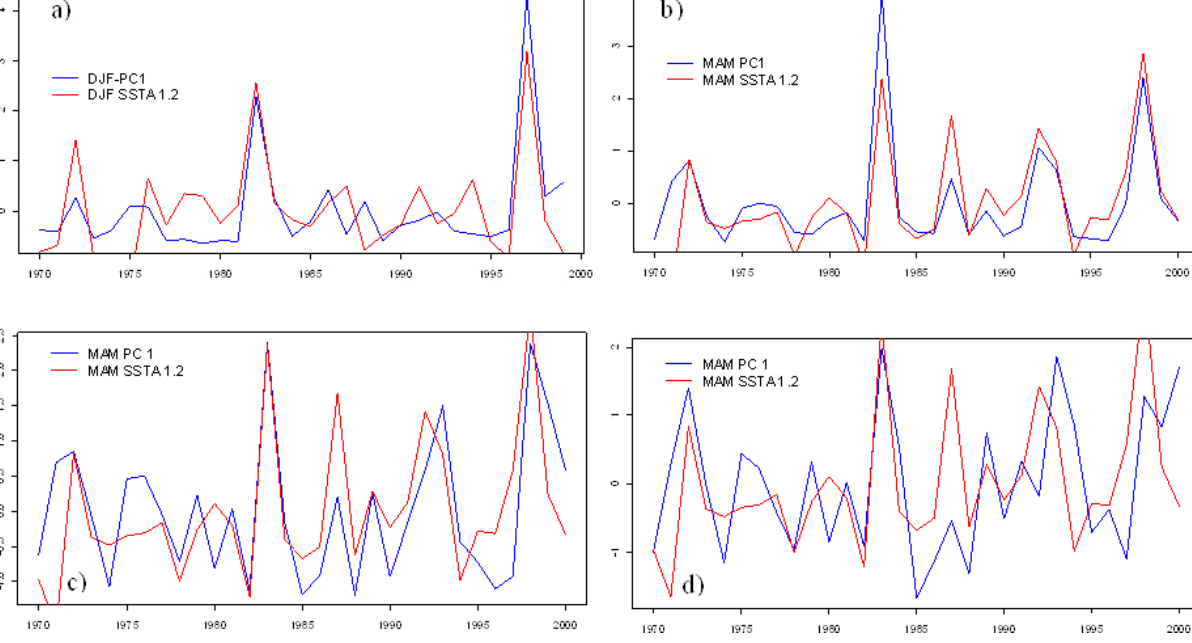
Fig. 4. (a) Normalized score time series of PC1 and seasonal SSTA 1.2, for (a) DJF and lower basin, (b) MAM and lower basin, (c) MAM and middle basin and (d) MAM and upper basin.